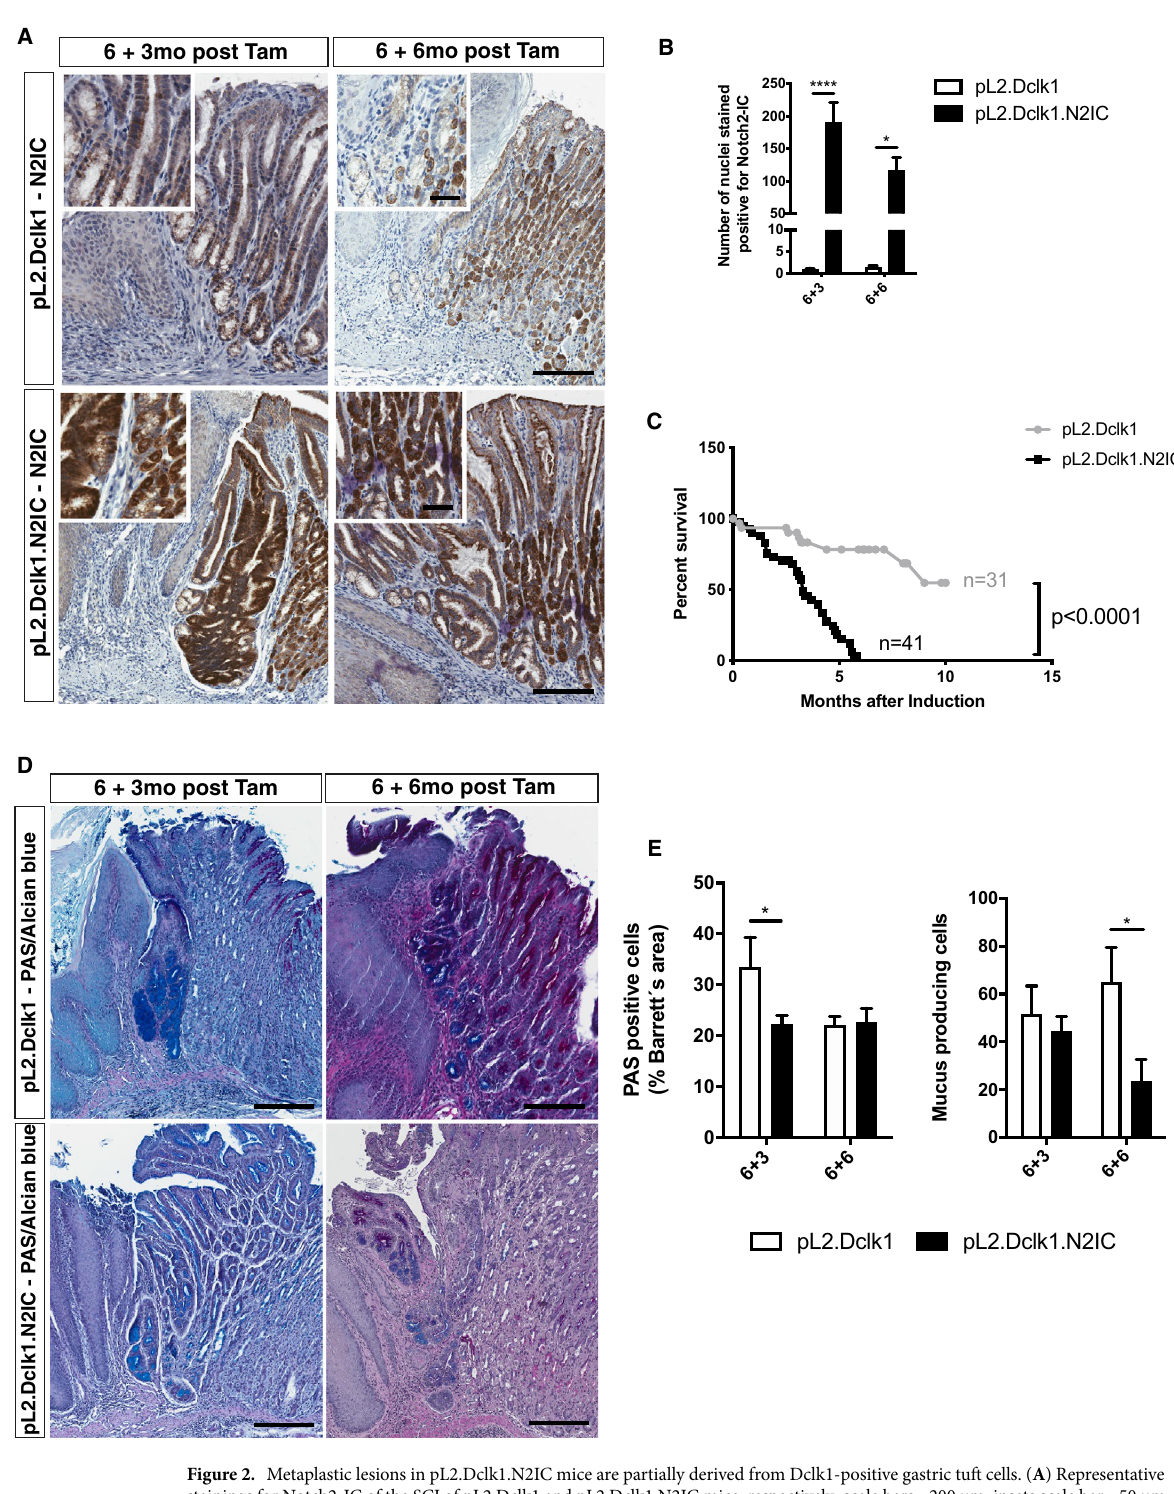
Figure 2. Metaplastic lesions in pL2.Dclk1.N2IC mice are partially derived from Dclk1-positive gastric tuft cells. ( A ) Representative stainings for Notch2-IC of the SCJ of pL2.Dclk1 and pL2.Dclk1.N2IC mice, respectively; scale bars = 200 µm; insets scale bar = 50 µm. ( B ) Histopathologic scoring of Notch2-IC stained nuclei in pL2.Dclk1.N2IC tissues compared to pL2.Dclk1 controls (6 + 3 n = 25 pL2. Dclk1.N2IC, n = 11 pL2.Dclk1 controls; ordinary two-way ANOVA, p ≤ 0.0001; 6 + 6 n = 20 pL2.Dclk1.N2IC, n = 7 pL2.Dclk1 controls; ordinary two-way ANOVA, p = 0.046). ( C ) Survival analysis of pL2.Dclk1.N2IC compared to pL2.Dclk1 controls shows significant decrease of median overall survival in pL2.Dclk1.N2IC mice (n = 41 pL2.Dclk1.N2IC; n = 31 pL2.Dclk1 controls; Median survival pL2. Dclk1.N2IC = 3.3 months; Median survival pL2.Dclk1 ≥ 10 months; log-rank (Mantel-Cox) test, Chi square = 25,91, p ≤ 0.0001). ( D , E ) Histopathologic analysis and scoring in pL2.Dclk1.N2IC tissues compared to pL2.Dclk1 controls for PAS-positive cells at the SCJ (6 + 3 n = 21 pL2.Dclk1.N2IC, n = 6 pL2.Dclk1 controls; ordinary two-way ANOVA, p = 0.025; 6 + 6 n = 9 pL2.Dclk1.N2IC, n = 2 pL2.Dclk1 controls) and mucous producing cells (6 + 3 n = 21 pL2.Dclk1.N2IC, n = 6 pL2.Dclk1 controls; 6 + 6 n = 6 pL2.Dclk1.N2IC, n = 4 pL2. Dclk1 controls, ordinary two-way ANOVA, p = 0.049); scale bars = 200 µm; error bars indicate